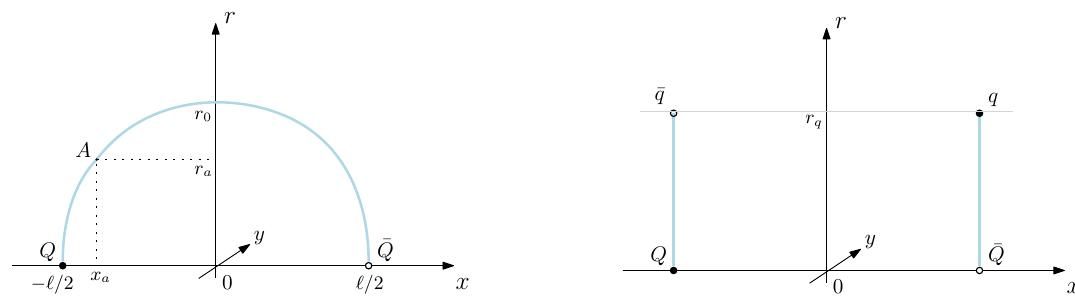
Figure 13 . A selection of string configurations for the ground state energy of a static quark- antiquark pair. Here r 0 = r | x =0